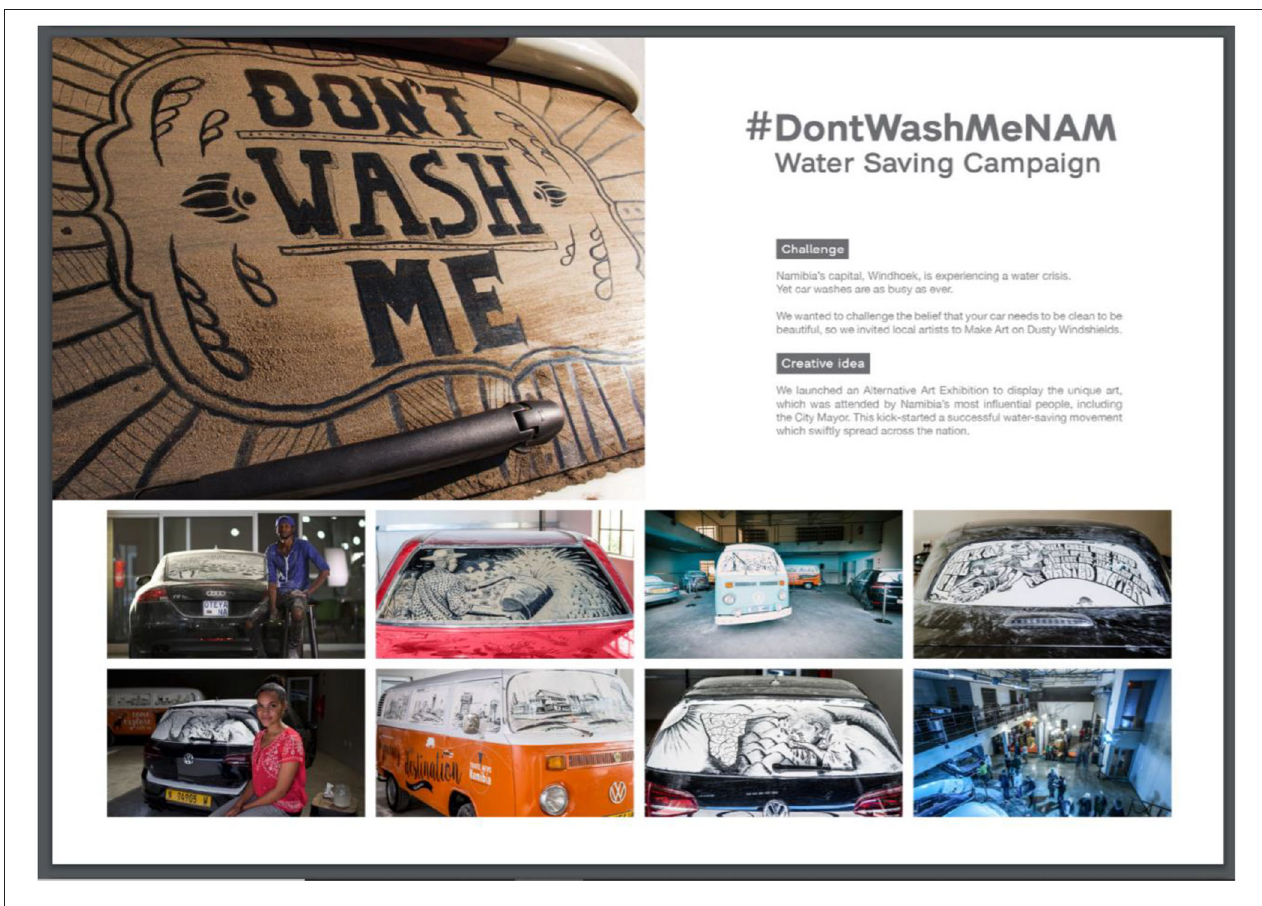
FIGURE 3 | #DontWashMeNAM